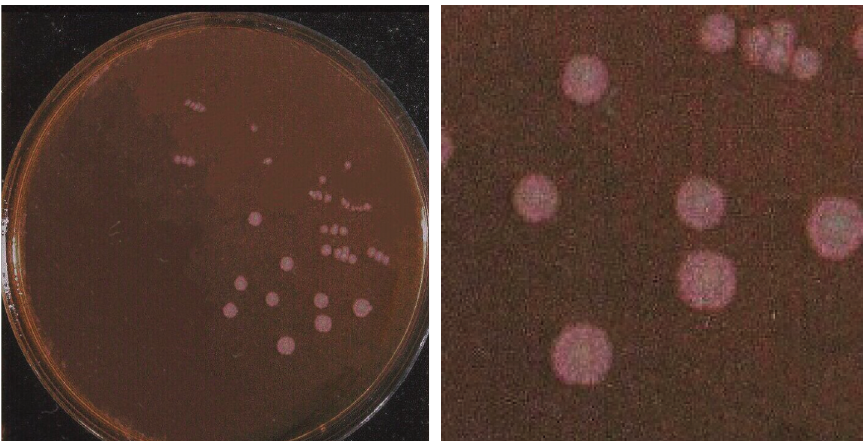
Figure 15: The rupture figure of the microbial capsule under pressure.